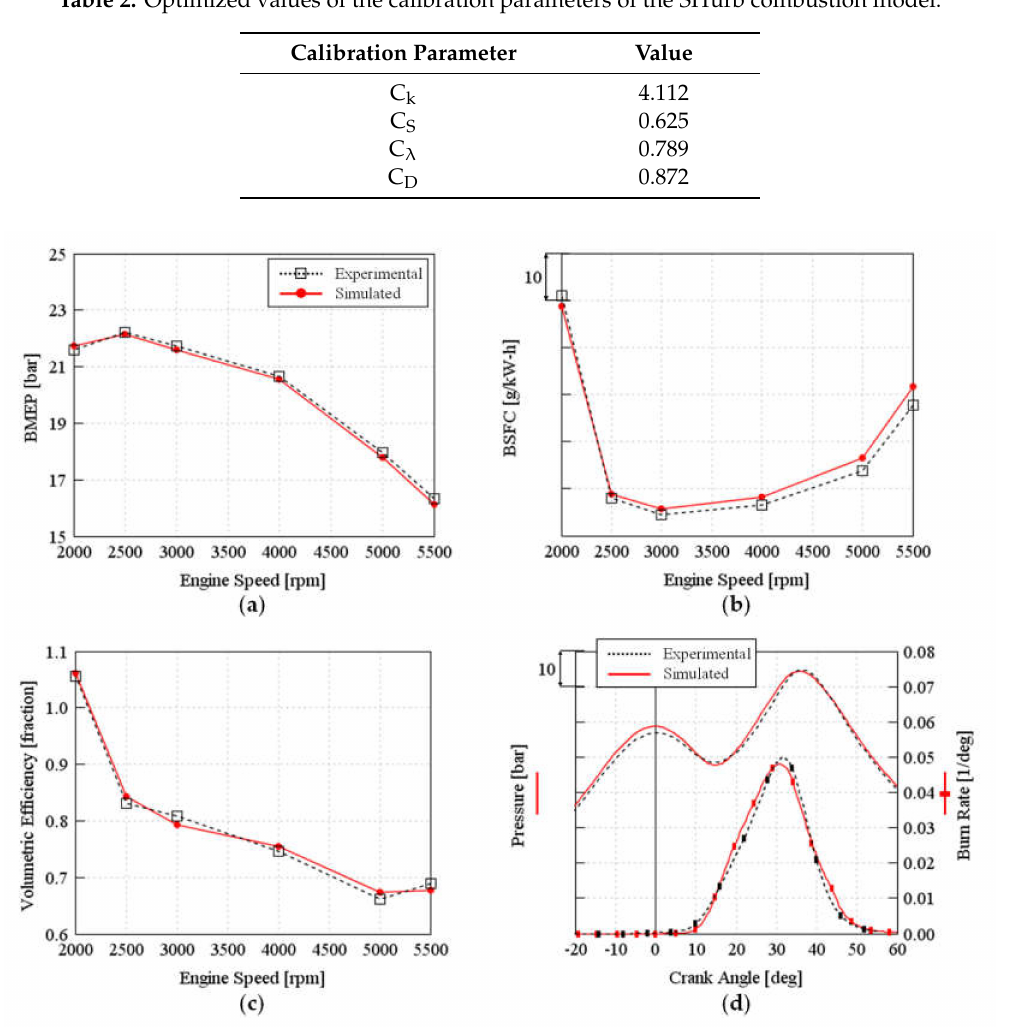
Table 2. Optimized values of the calibration parameters of the SITurb combustion model.